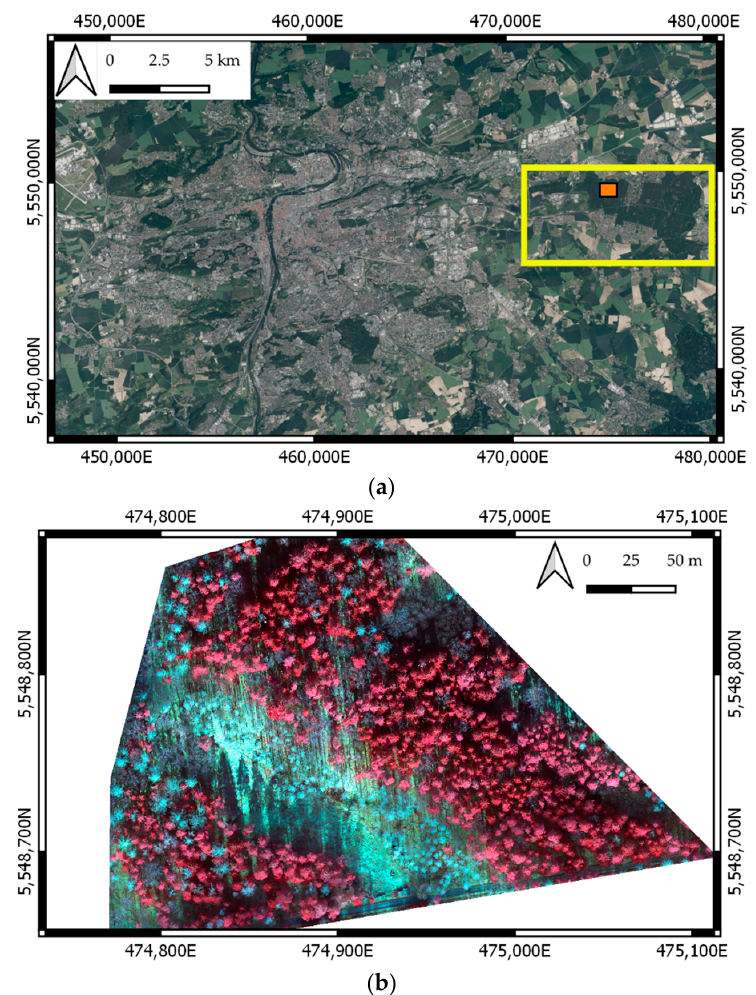
Figure1. Studyarea. ( a )LocationofKl á noviceforest(yellowrectangle)andstudyarea(orangerectangle) in Prague metropolitan area, ( b ) Study area on a multispectral image. The coordinate reference system is WGS 84 / UTM zone